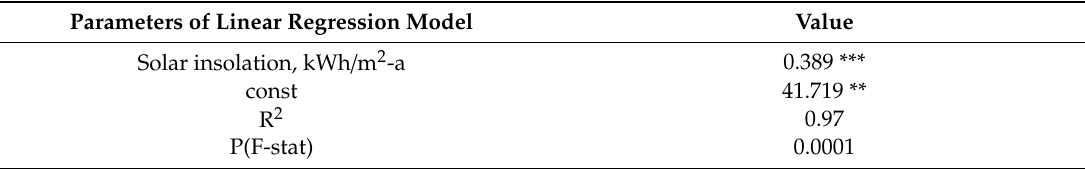
Table 4. Dependence of performance (specific solar yield, kWh / m 2 -a) of the average large-scale flat plate solar collector on horizontal